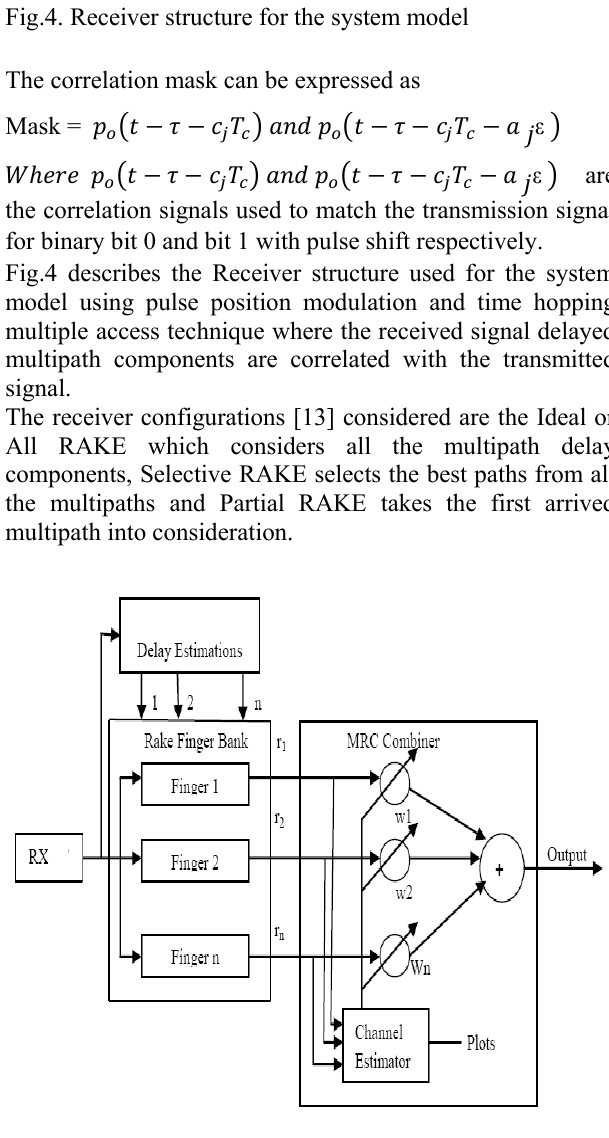
Fig.5. RAKE Receiver